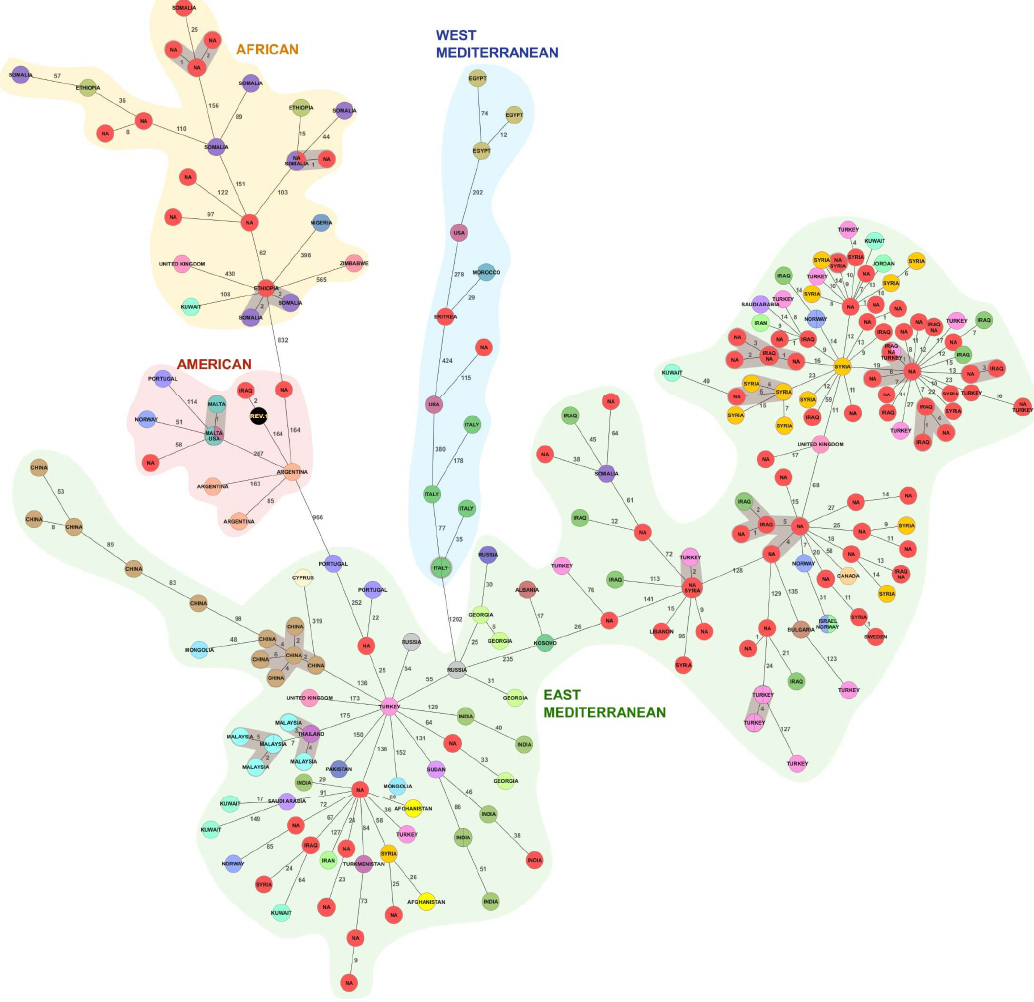
Figure 3. Minimum spanning tree (MST) generated for 242 isolates of B. melitensis using the gene-by-gene approach. MST was calculated by pairwise comparison of 2704 target genes with missing values ignored. Nodes correspond to unique profiles and are colored according to the published country of isolation and the branches correspond to the number of discriminating loci. Strains obtained from patients in Sweden are depicted in red and B. melitensis vaccine strain Rev.1 is shown in black. Complexes of genotypes within a distance of six alleles are highlighted in gray.